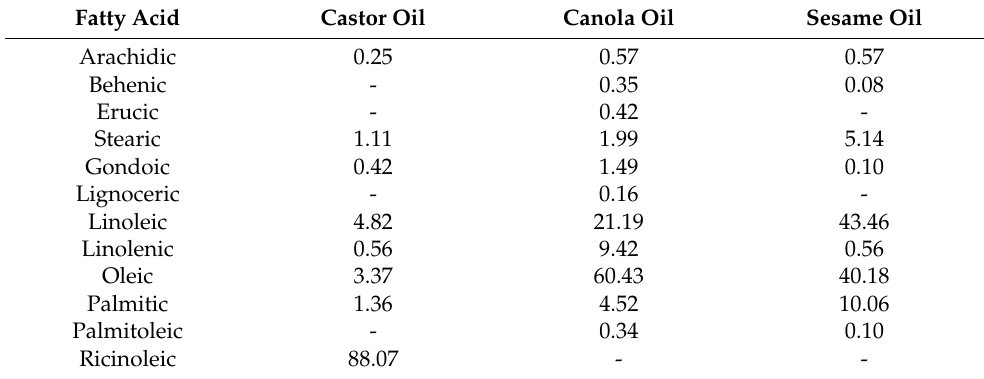
Table 3. Fatty acid composition of castor, canola, and sesame oils, data from [32].